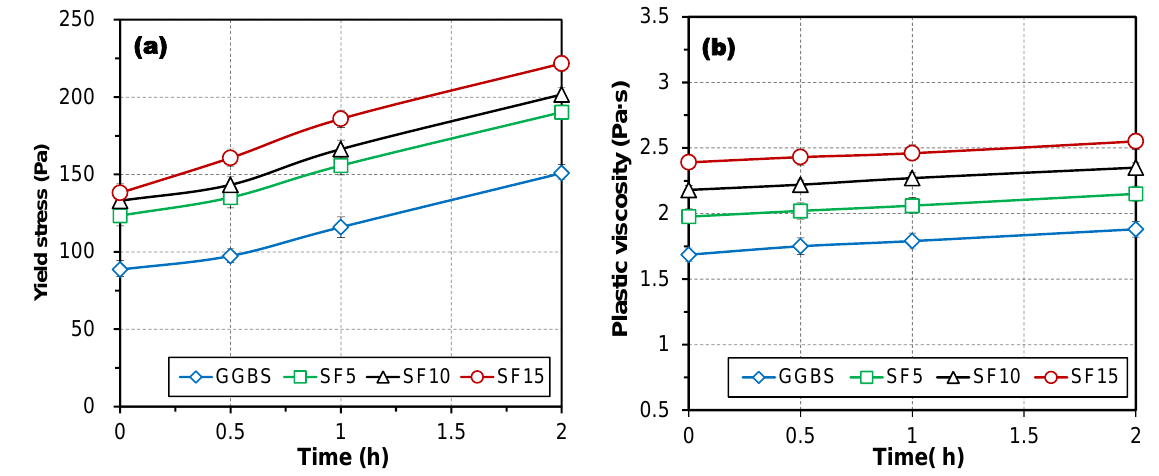
Figure 7. Evolution of time-dependent yield stress ( a ) and viscosity ( b ) of AAS-CPB specimens with diverse SF amounts.